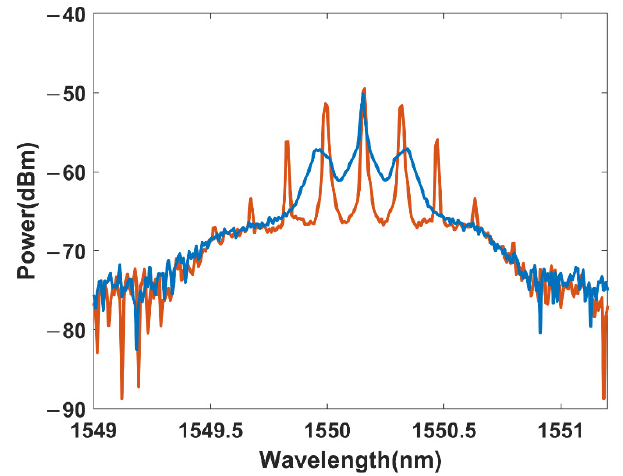
Figure 1. The spectra at the end of 25 km single mode optical fiber when the input power is 400 mW: blue (without seed), red (with seed).